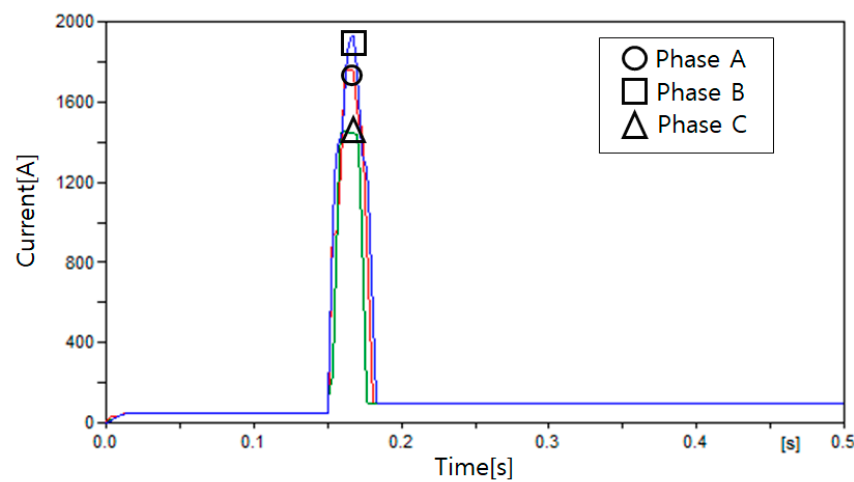
Figure 13. Fault location in Case 3.